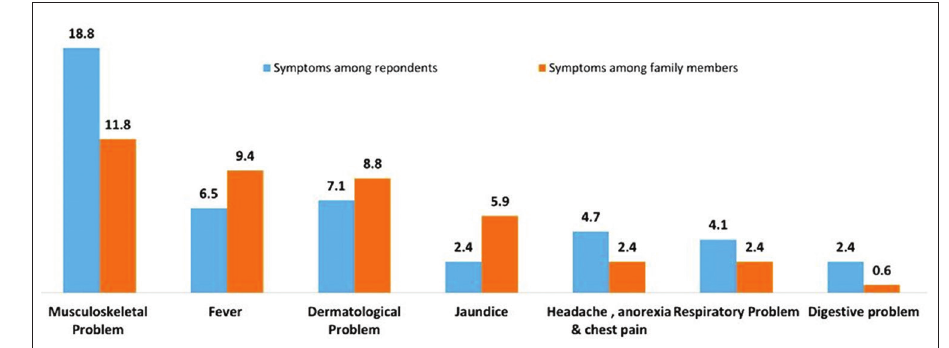
Figure-4: Symptomatic Z/D/S Table-2: Relationship between different exposure and existing self-reported Z/D/S condition among respondents. Variable